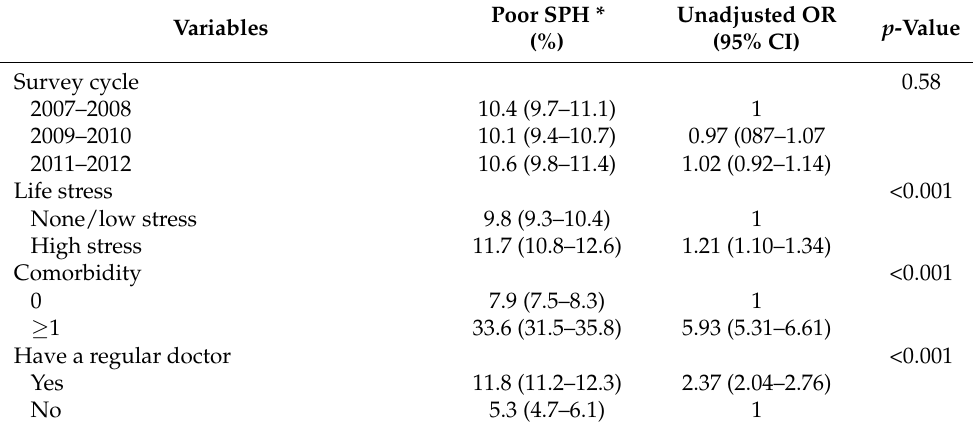
* Percentages weighted to the Canadian population. Bold values indicate statistical significance.